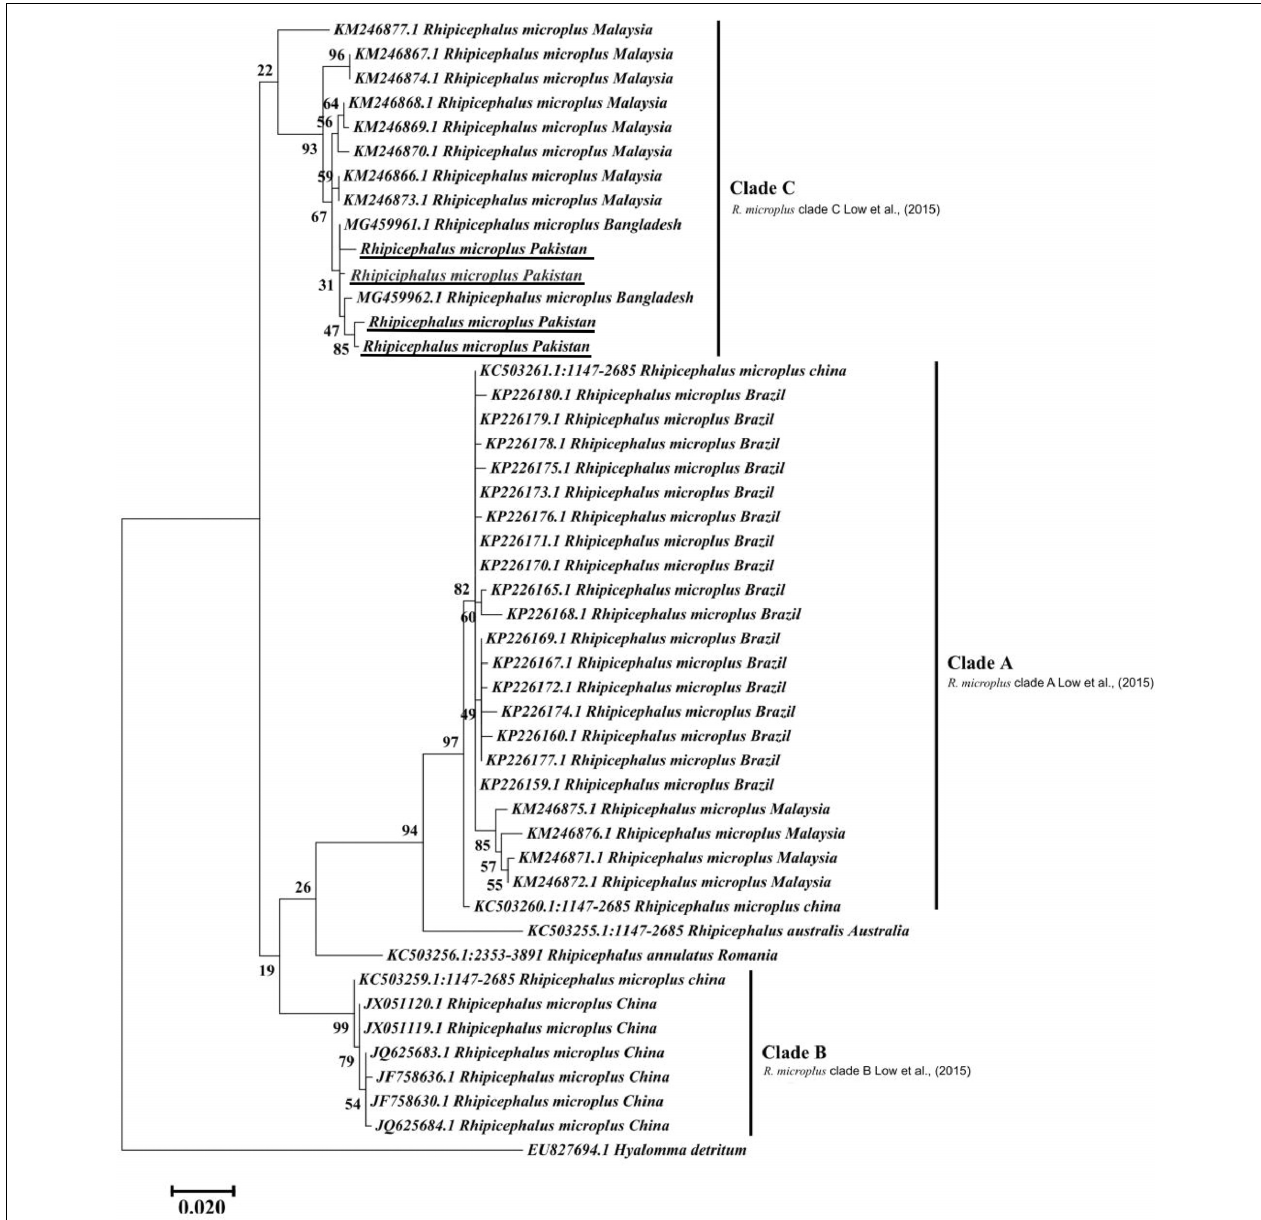
FIGURE 3 | Maximum likelihood tree inferred from COX1 sequences of the genus Rhipicephalus and using Hyalomma sequence as outgrowth. GenBank accession numbers are followed by species name and location of collection. Clade A includes R. microplus ticks from America, Malaysia, and China, clade B includes tick from China and clade C includes ticks from Pakistan, India, Bangladesh, Myanmar, and Malaysia. Support values (Bootstrapping values) were indicated at each node. The bar represents 0.020 substitutions per site. Sequences obtained in the present study were